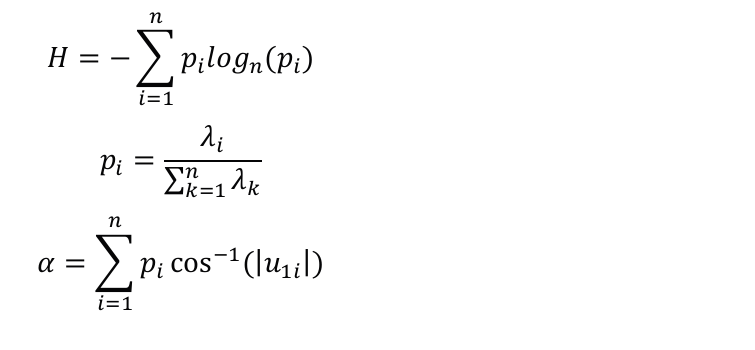
Figure 3. ( Left) RGB false color composite of Radarsat-2 quad-polarized data with R = double bounce, G = volume scattering, B = odd bounce; ( Right) RGB false color composite of co-polarized TerraSAR-X data with R = double bounce, G = odd bounce, B = difference between double and odd bounce. Data are shown as sigma nought